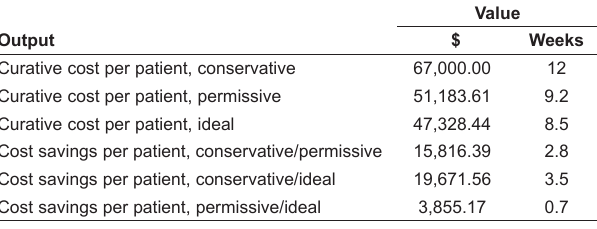
TABLE 3 Output values for